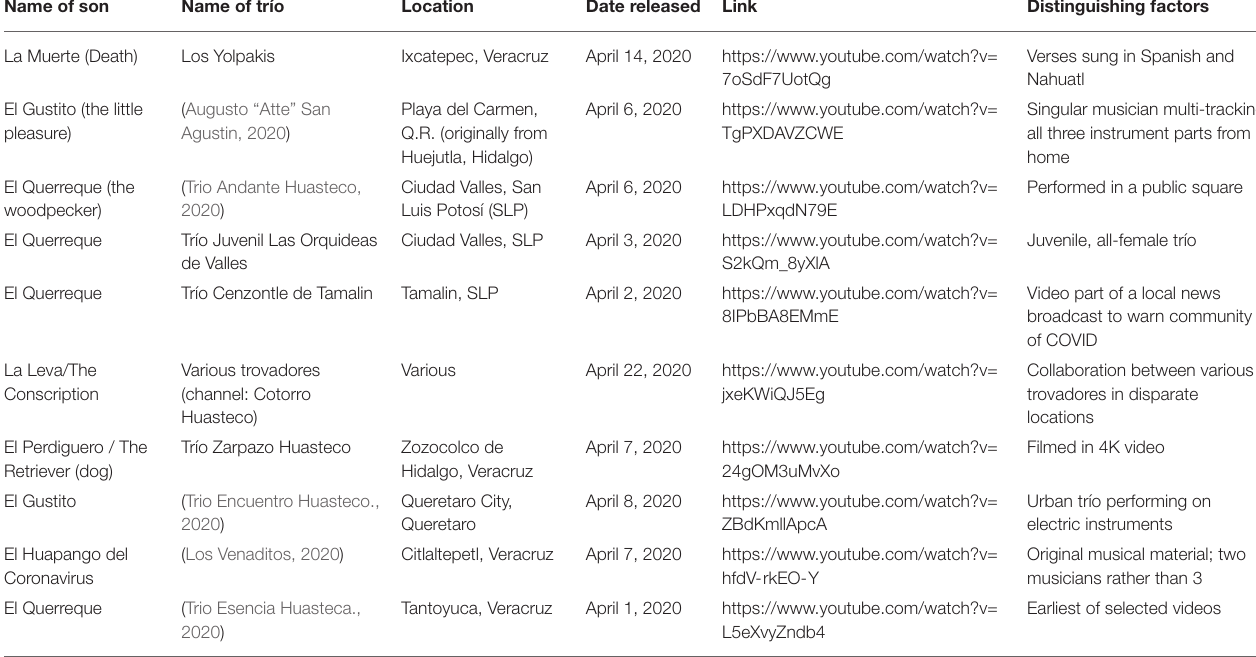
TABLE 1 | Selected examples of sones featuring COVID-19 verses that are discussed in this